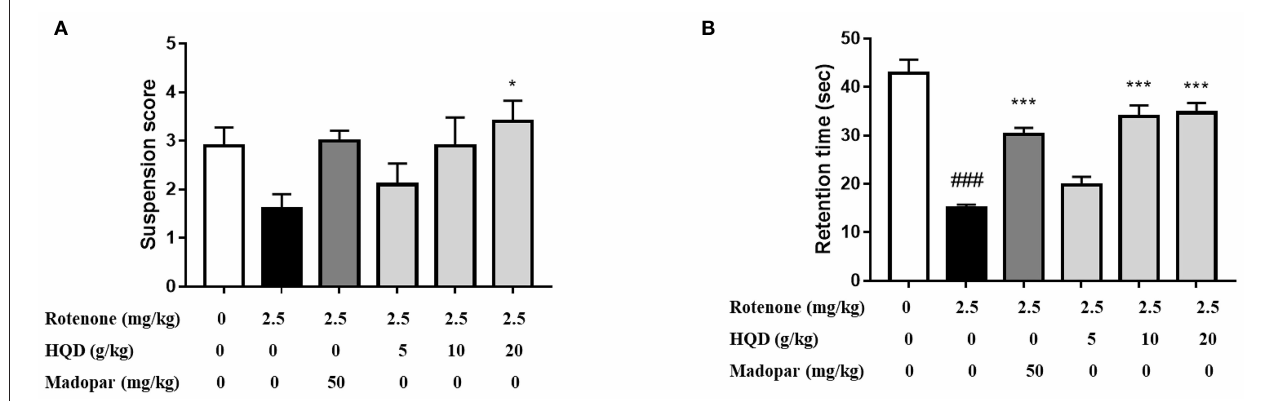
FIGURE 4 | The improvement effects of HQD on muscle strength of rotenone-induced PD rats. (A) Suspension score in suspension test. (B) The retention time in inclined plate test. ### P < 0.001 vs. control group; * P < 0.05, *** P < 0.001 vs. rotenone group ( n = 10).